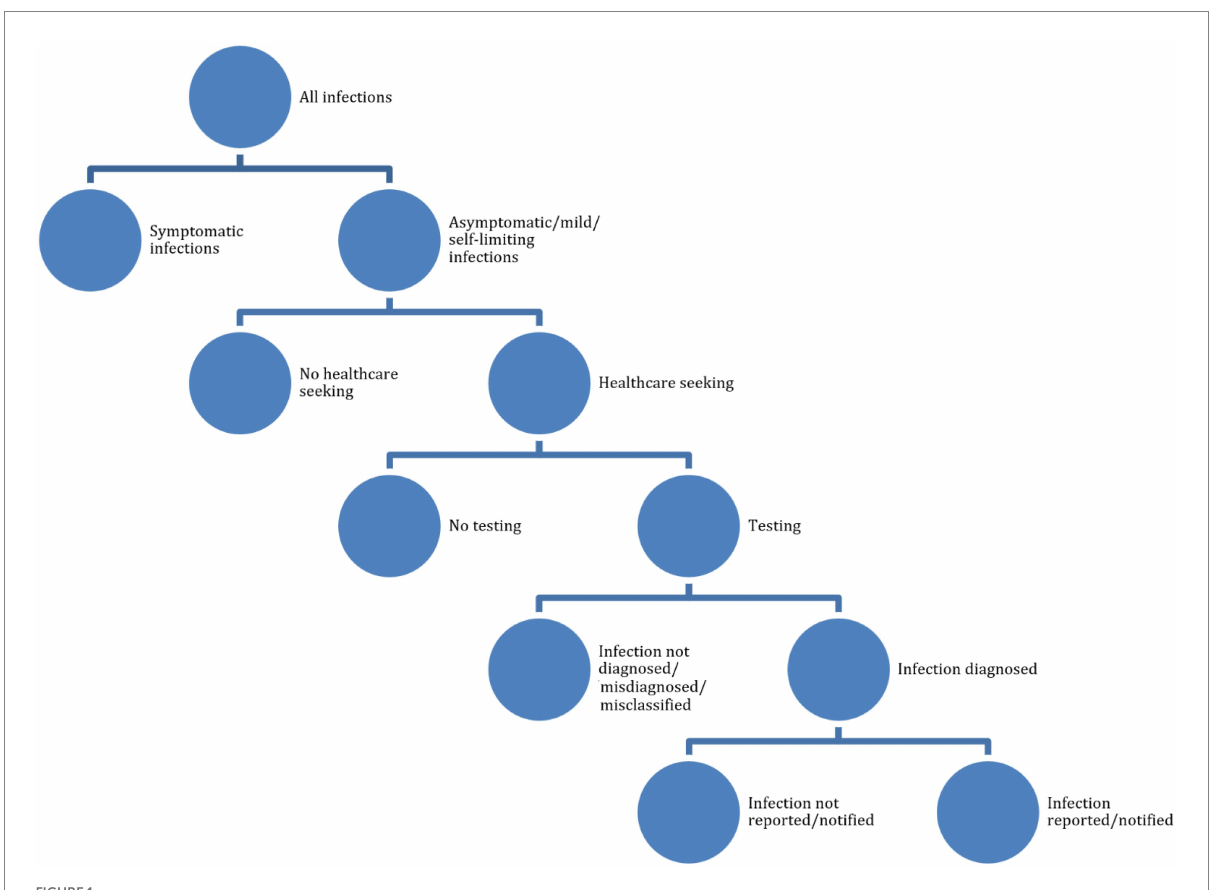
FIGURE 1 Pictorial flowchart of